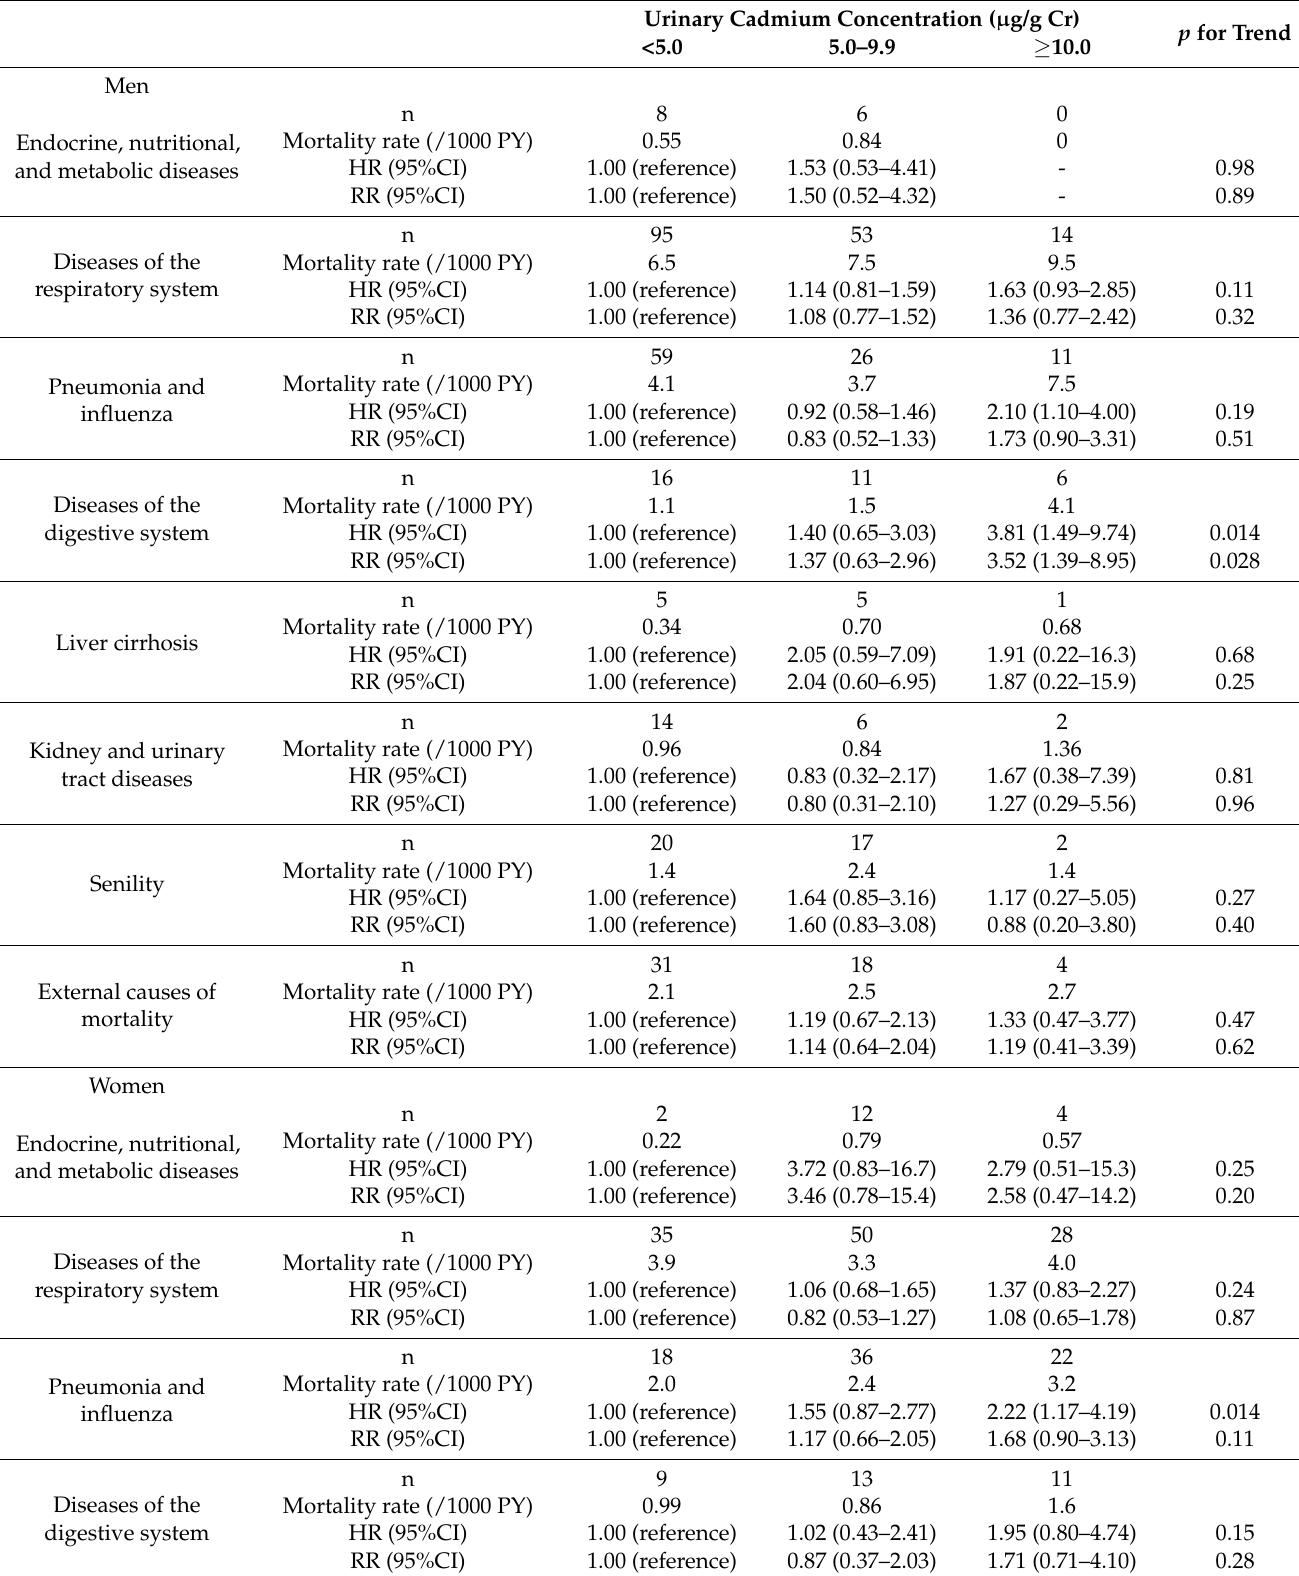
Table 5. Risk of mortality from non-cancer/non-circulatory diseases according to the urinary Cd concentration in the participants with a urinary β 2-MG level less than 1000 µ g/g